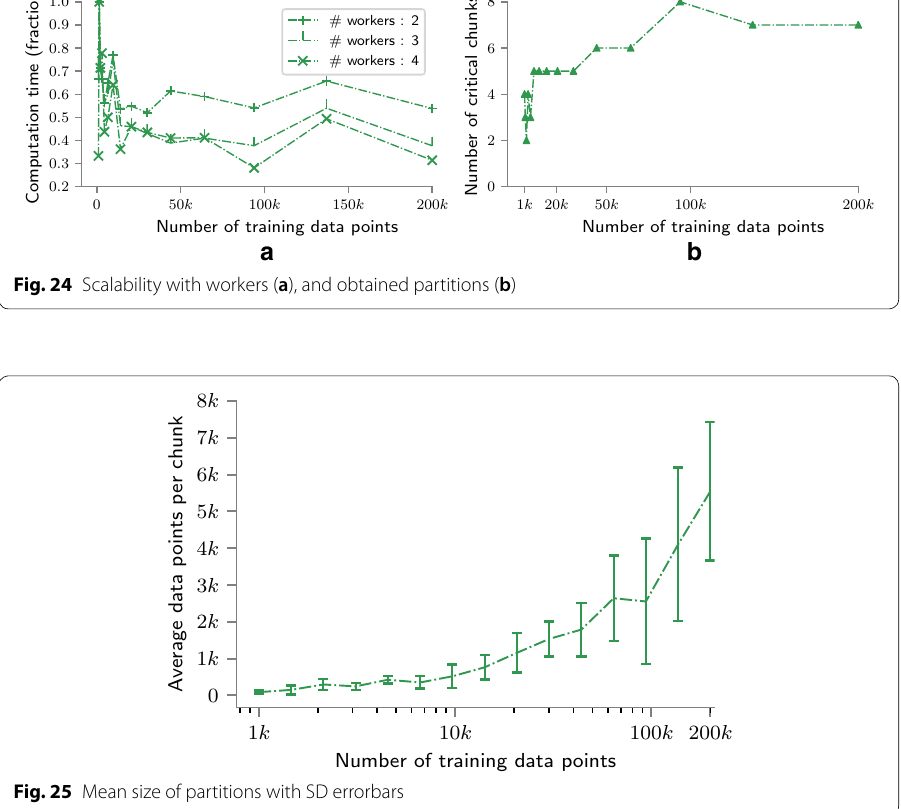
LIBSVM with shrinking heuristic is also plotted. An accuracy plot, Subfigure (b), and a plot for the number of partitions in Fig. 21 are also presented.